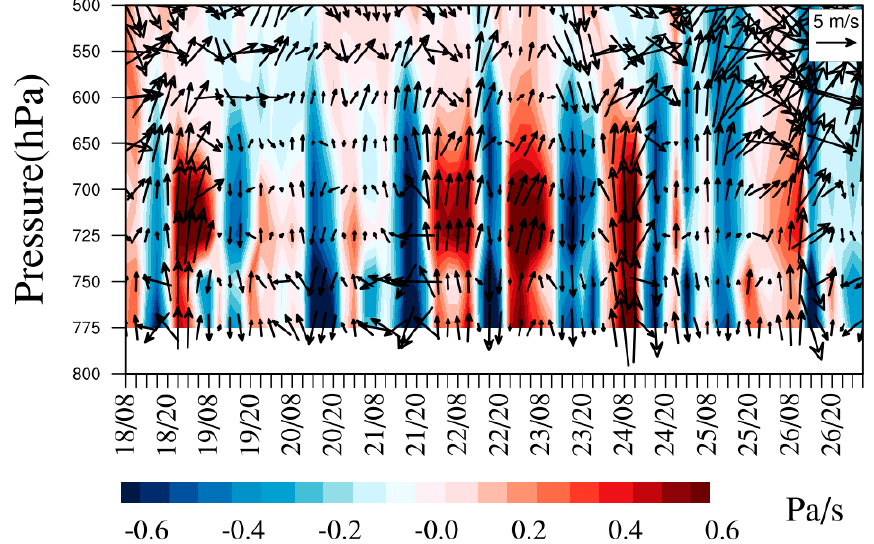
Figure 4. Time series of the wind field and vertical velocity for MERRA-2 during the observation period.